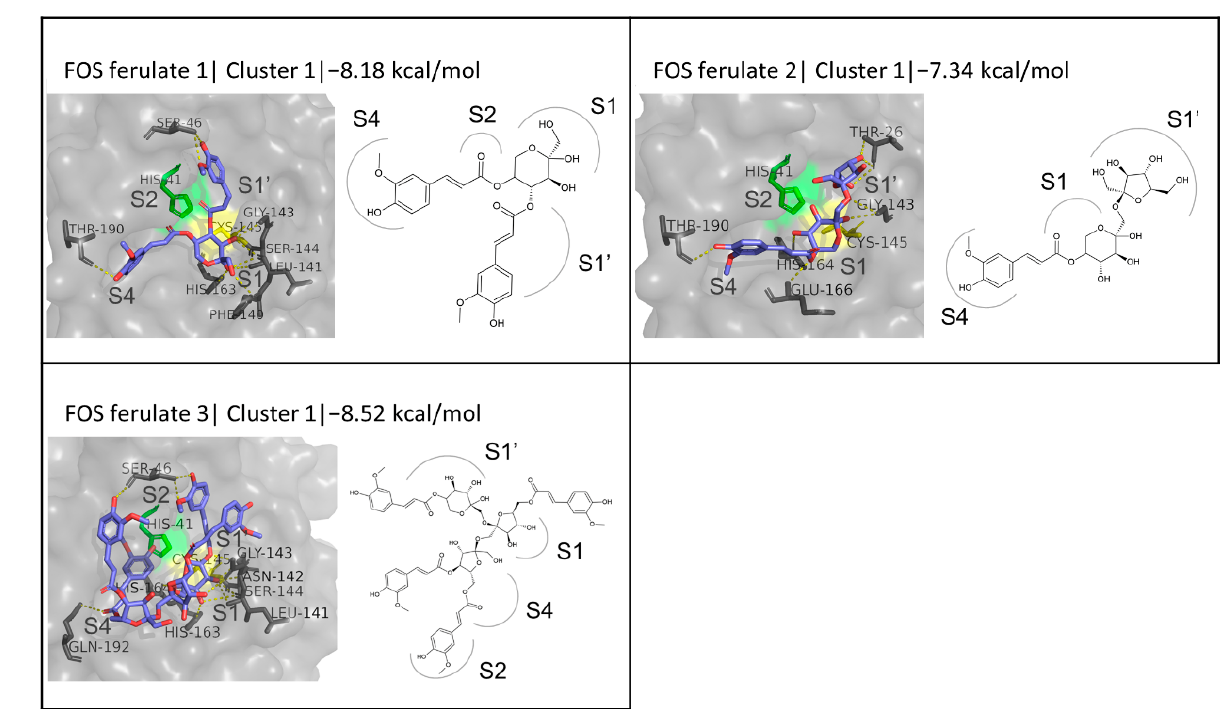
Figure 9. Structure and binding of the three suggested FOS ferulate structures at the active site of M pro .